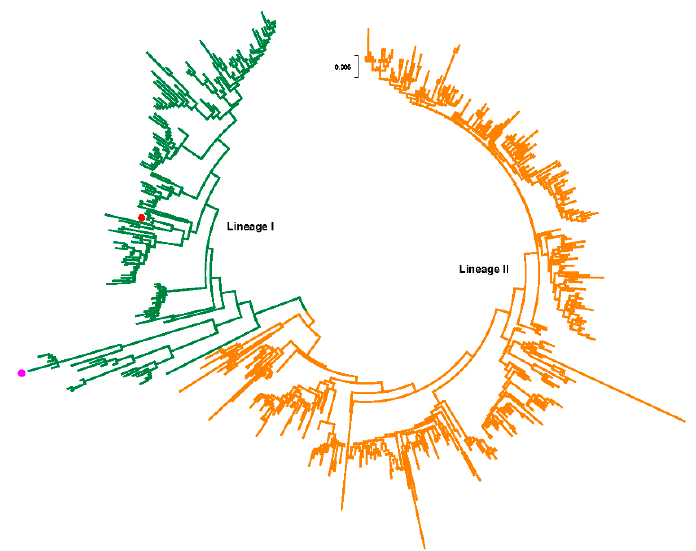
Figure 1. Phylogenetic relationship of RVA G1 strains based on the complete genome of the VP7 gene using maximum likelihood method. Red and light purple dots indicate Rotarix and RotaTeq vaccine reference strains, respectively.